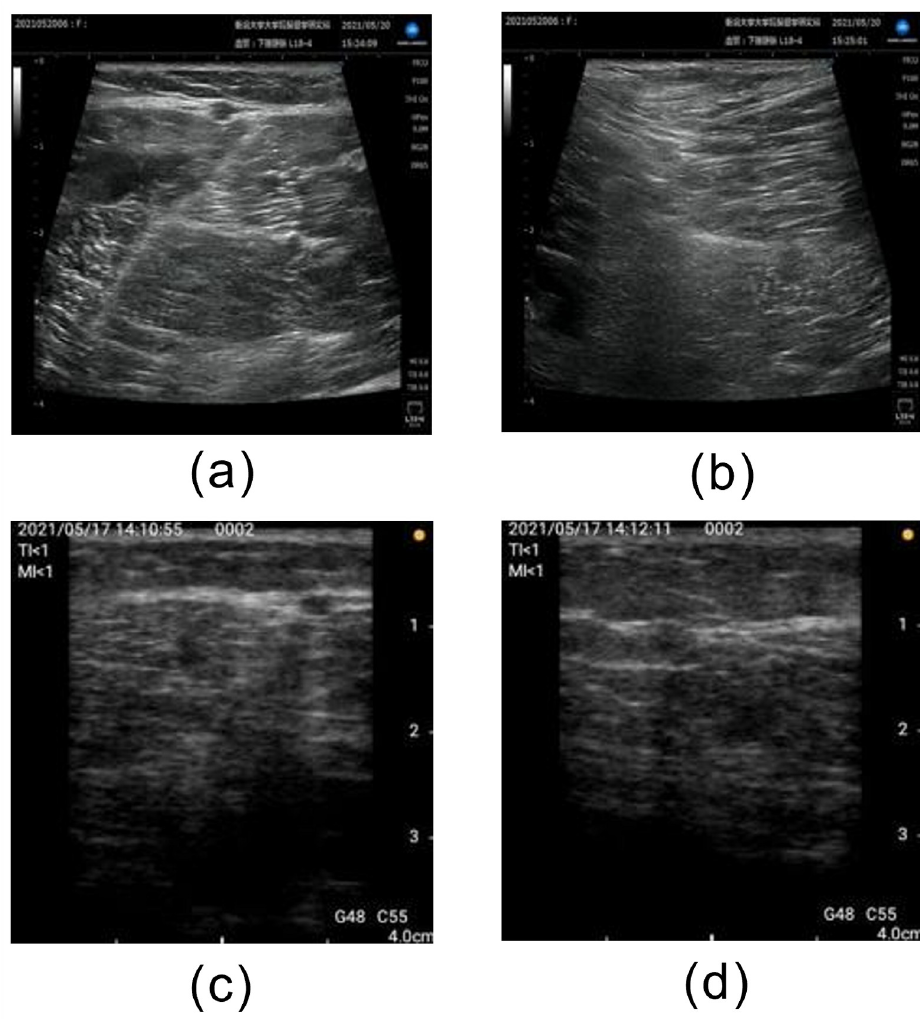
Fig 4. Examples of correctly classified unsatisfactory images. (a) Short axis acquired by stationary ultrasonography equipment, (b) Long axis acquired by stationary ultrasonography equipment, (c) Short axis acquired by portable ultrasonography equipment, and (d) Long axis acquired by portable ultrasonography